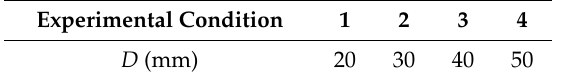
Table 3. Experimental condition.